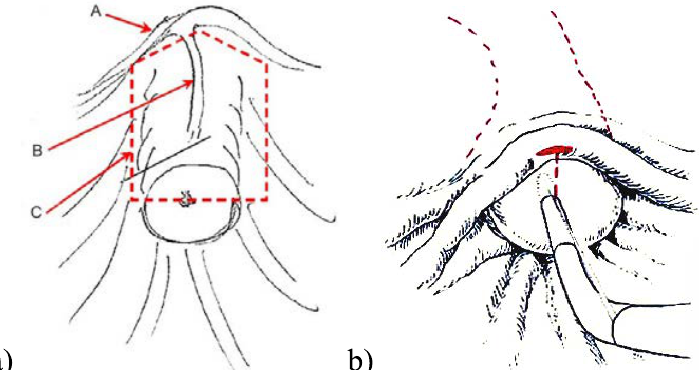
Figure 2 Schematic illustration of the (a) safe sphincterotomy area (A–plica transversa; B–plica longitudinalis; C–safe incision area) and (b) transverse dimension for the incision